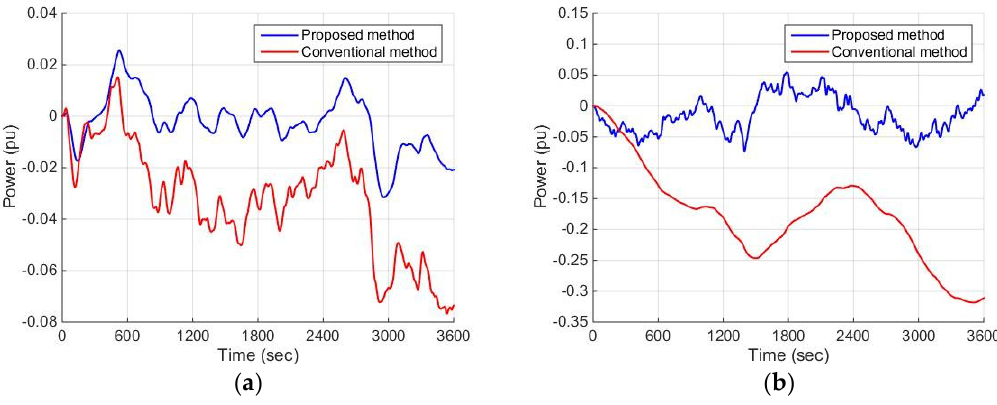
Figure 13. Frequency deviation with external disturbance and system parameter uncertainties: